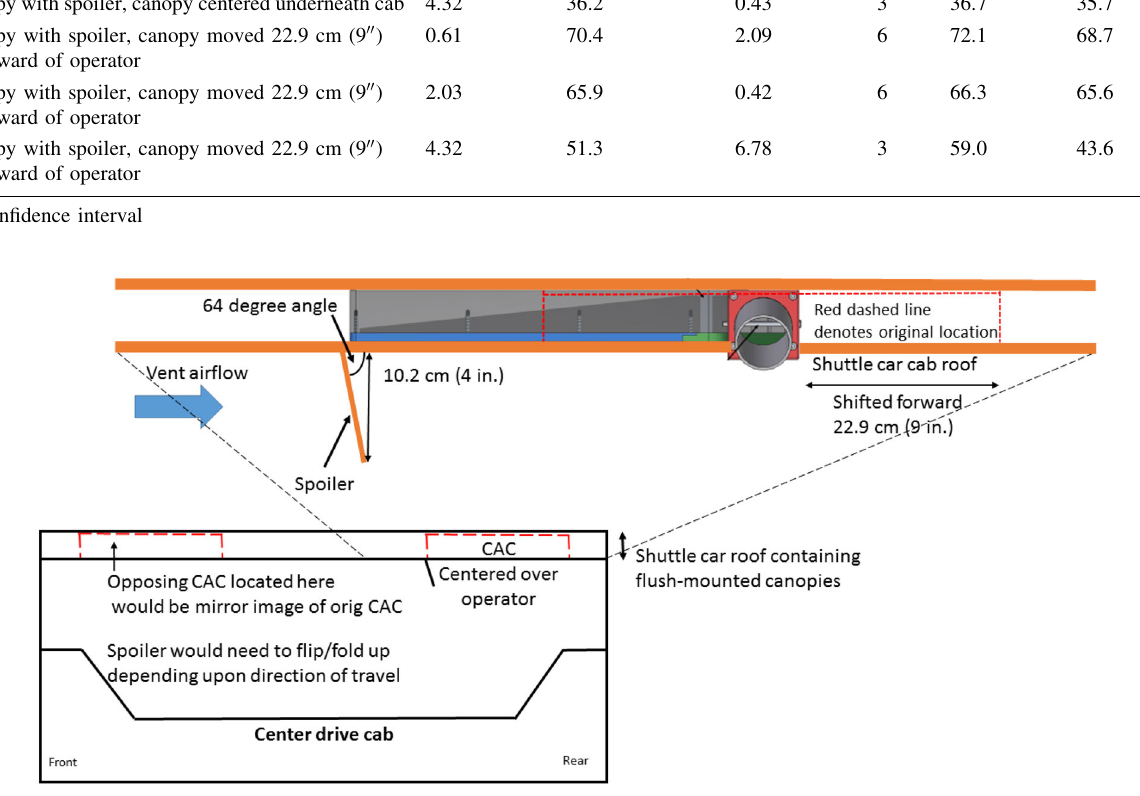
Fig. 11 Canopy air curtain built into cab roof, displaying forward shift of canopy location (9 in. forward) and spoiler to redirect ventilation